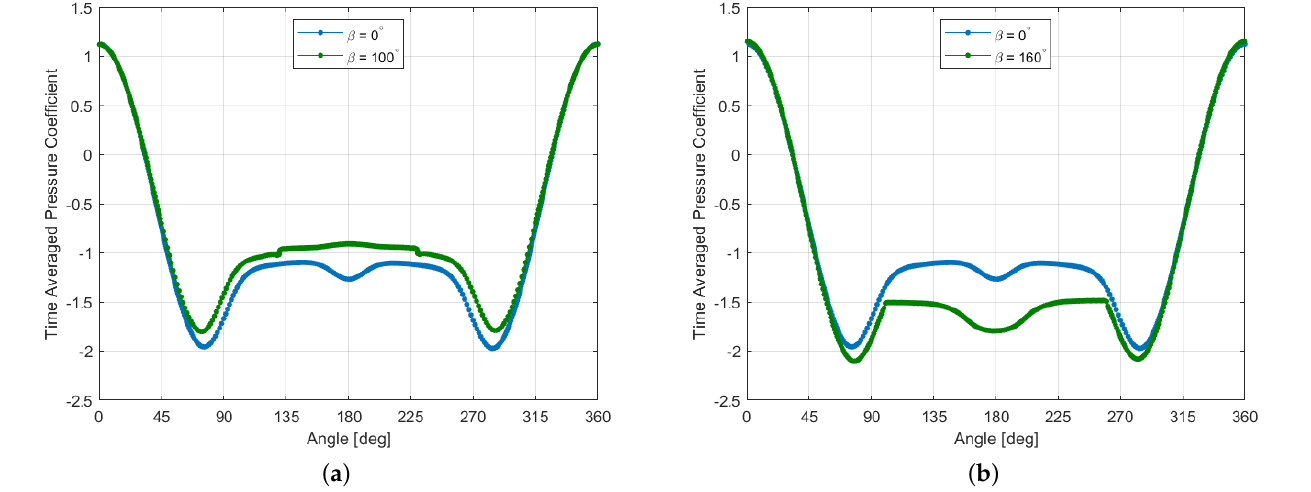
Figure 4. Time-averaged C p for the smooth cylinder and varying coating angle β at Re = 4.2 × 10 4 , constant thickness t / D = 14.3% and a porosity of 20 PPI. ( a ) β = 100 ◦ . ( b ) β = 160 ◦ .